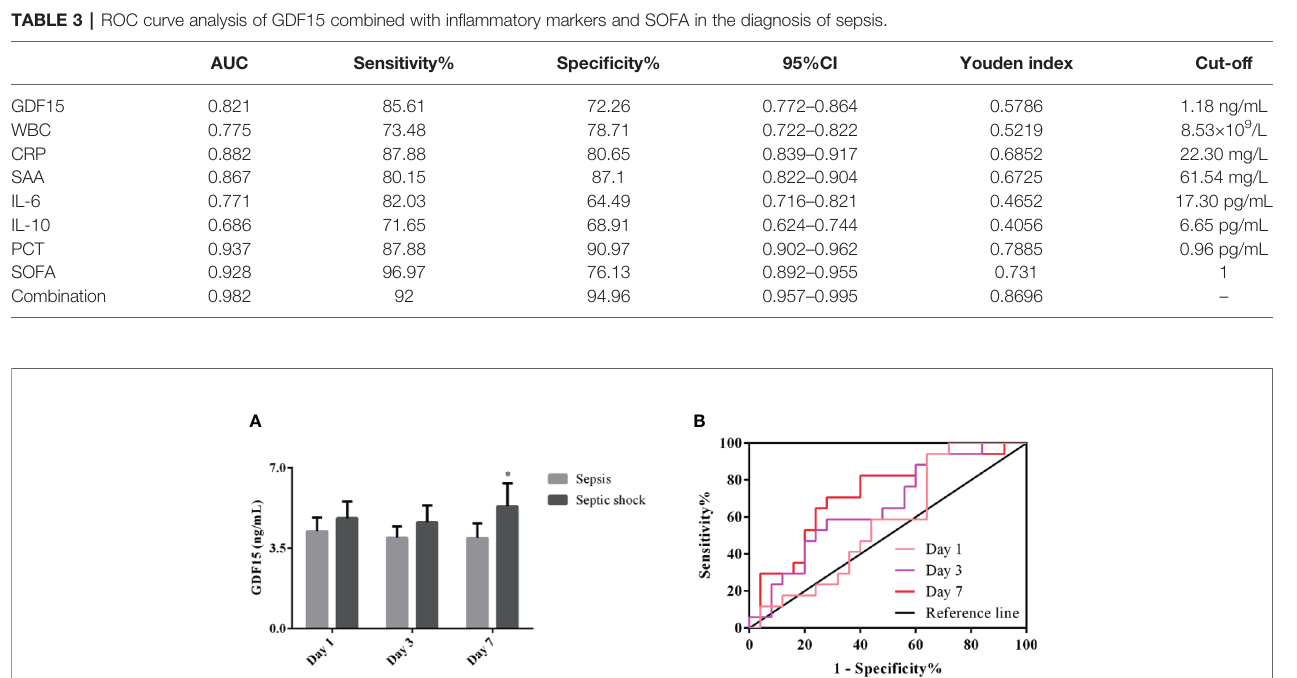
FIGURE 5 | Dynamic analysis of GDF15 in sepsis group and septic shock group. (A) the dynamic changes of GDF15 levels in sepsis group and septic shock group; (B) ROC curve of dynamic changes of GDF15 in differentiating sepsis from septic shock. * P < 0.05, compare with Day 7 of sepsis group.